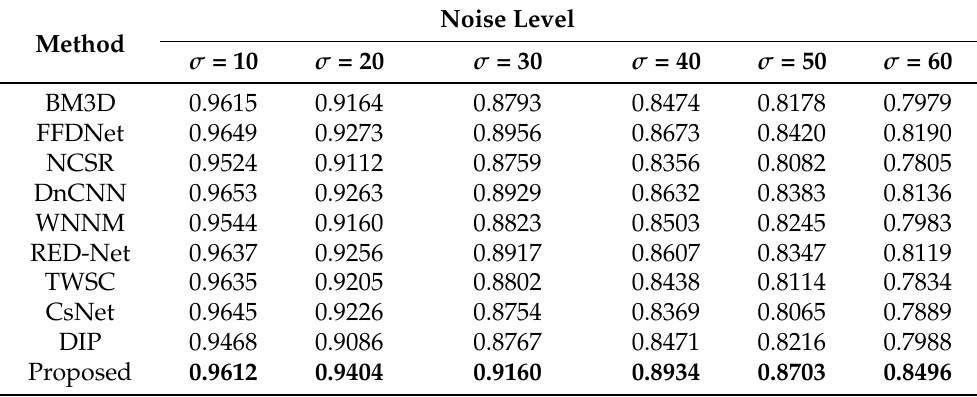
Table 14. Average FSIM results of different methods on 10 images in Flickr1024 with various noise